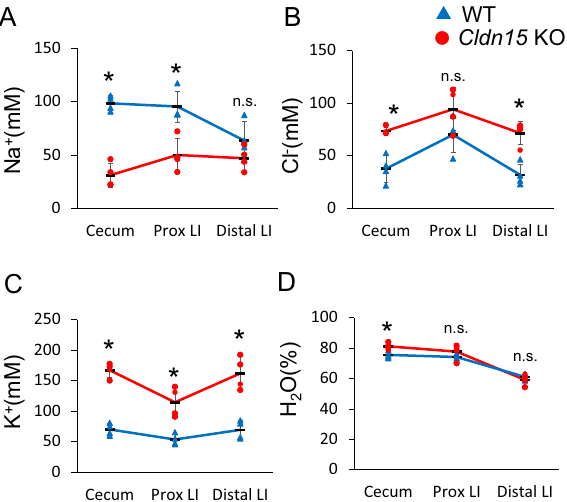
Figure 4. Electrolyte and water percentage in the luminal contents. The contents of each luminal segment were collected from Cldn15 KO mice (n = 4) and WT (n = 4), and the H 2 O content and ion concentrations were measured. ( A ) Na + concentration; ( B ) Cl − concentration; ( C ) K + concentration; ( D ) H 2 O content. The dots represent the individual points and the black bars represent the mean, error bars represent the SD. Statistical significance from left to right: ( A ) *P = 0.029; *P = 0.029; n.s. P = 0.200; ( B ) *P = 0.029; n.s. P = 0.343; *P = 0.029; ( C ) *P = 0.029; *P = 0.029; *P = 0.029; ( D ) *P = 0.029; n.s. P = 0.343; n.s. P = 0.686, Mann–Whitney U test, Cldn15 KO vs. WT. Prox LI proximal large intestine, Distal LI distal large intestine, Please see supplementary table 1 for data